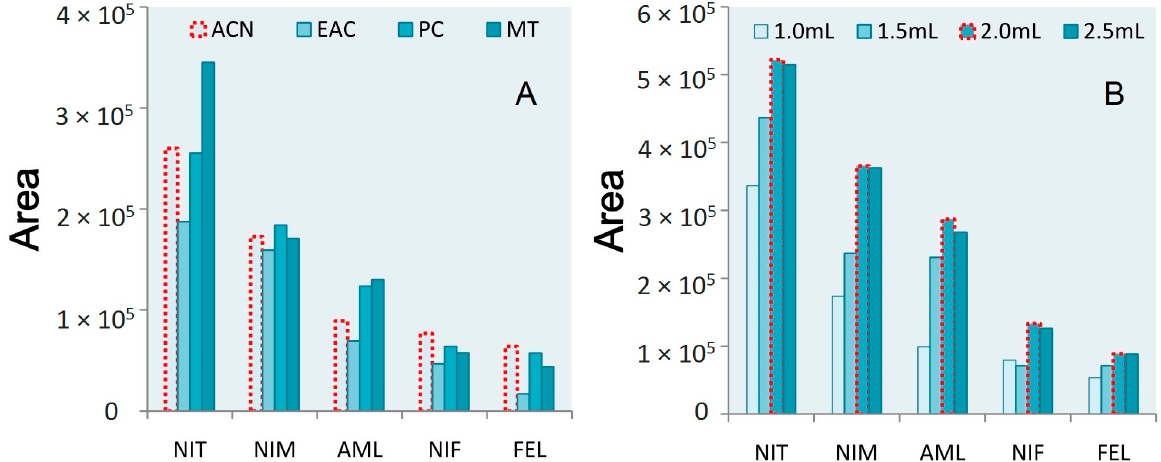
Figure 2. ( A ) The area results of five CCBs treated with different extraction solvents. ( B ) The area results of five CCBs treated with different volumes of extractants.